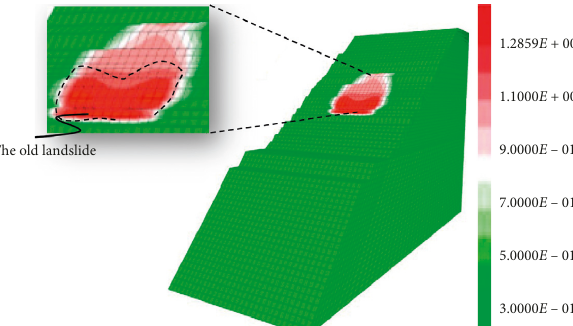
Figure 18: Displacement contour of the old landslide after stabilization.